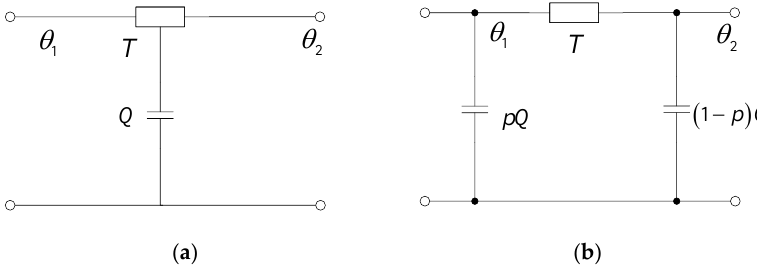
Figure 1. Lumped parameter model of a cylinder layer: ( a ) before equivalence and ( b ) the equivalent π circuit.